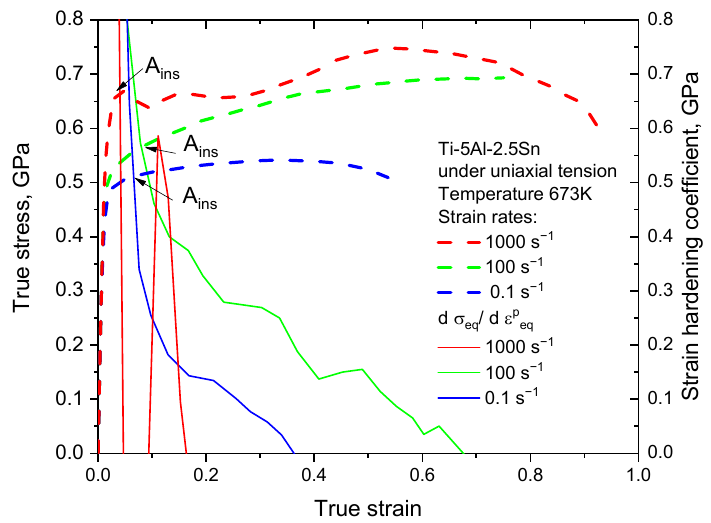
Figure 2. True stress versus true strain of Ti-5Al-2.5Sn and strain hardening coefficient versus true strain for smooth specimens under tension at strain rates of 1000 s − 1 , 100 s − 1 , and 0.1 s − 1 , and temperature of 673 ± 2